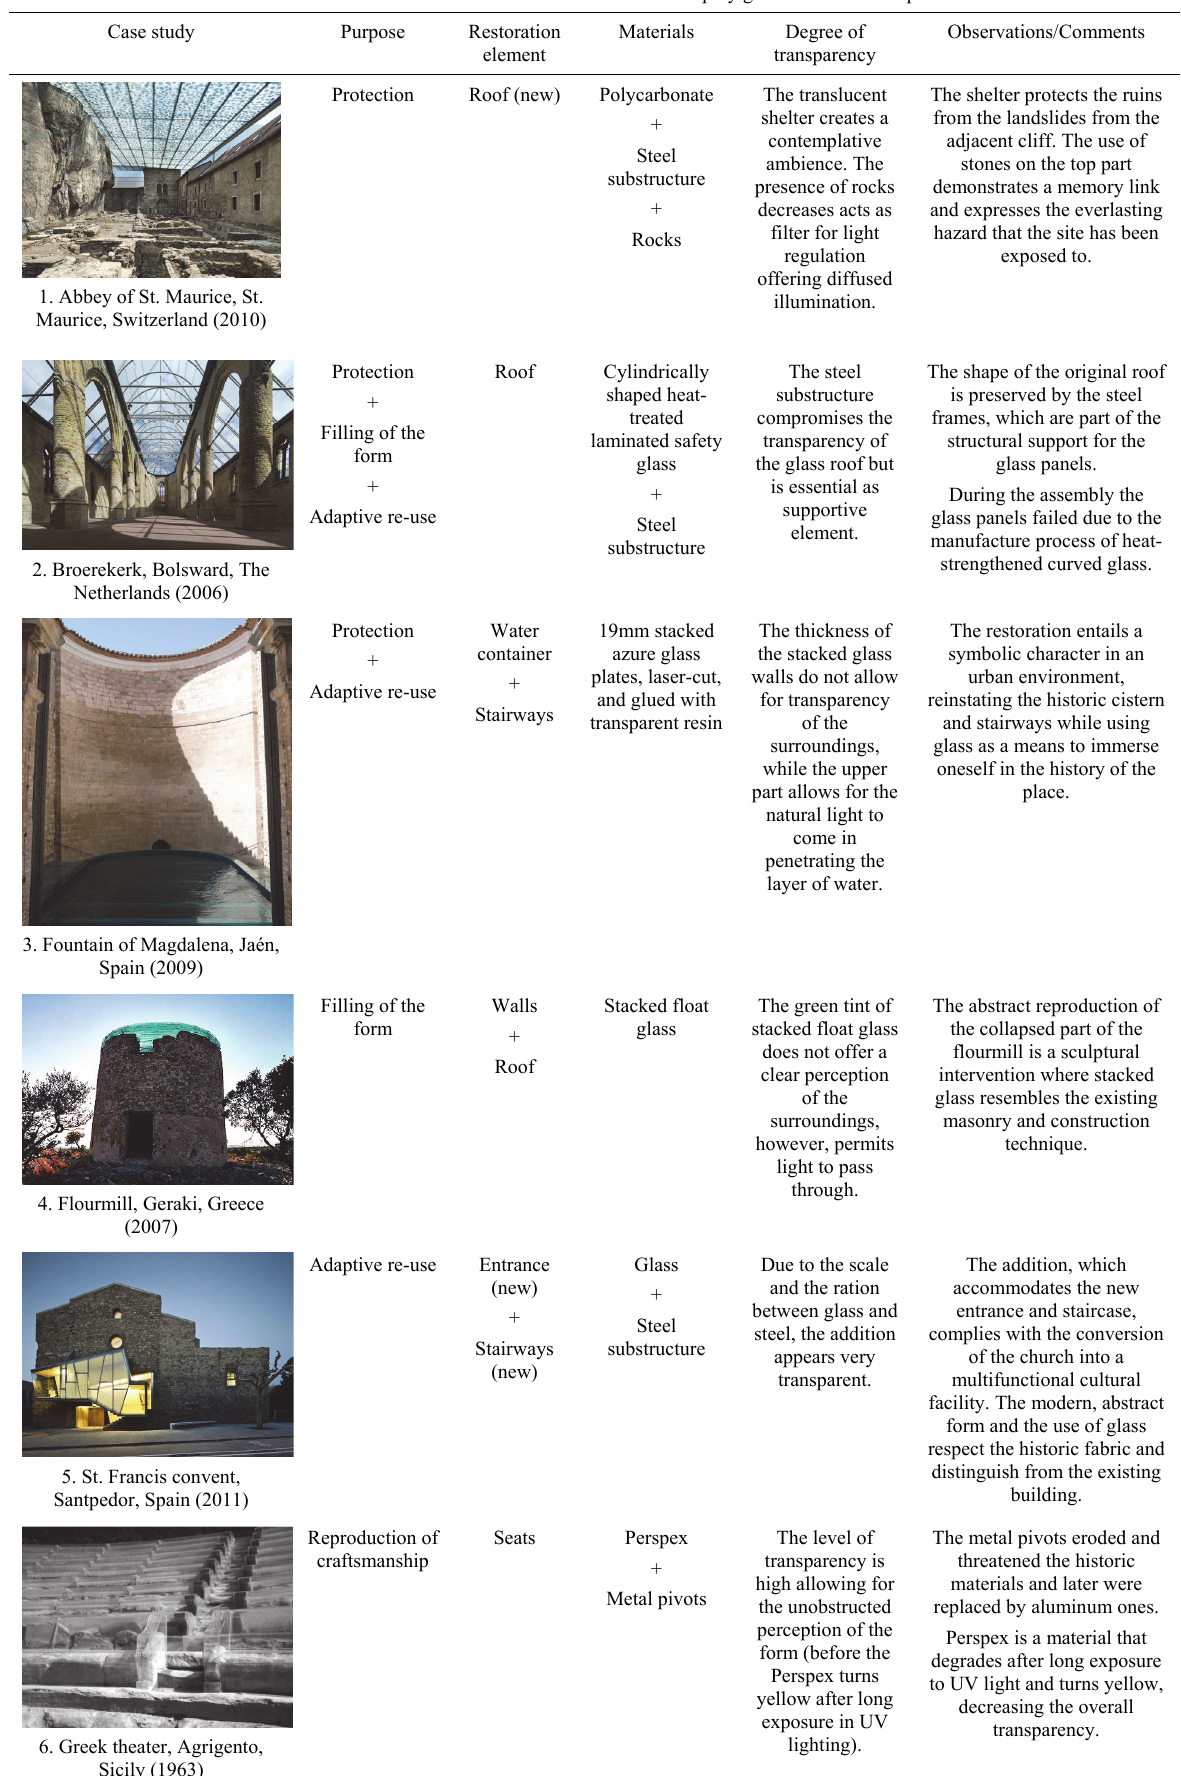
Table 2: Overview and assessment of restoration case studies that employ glass and other transparent materials. Case